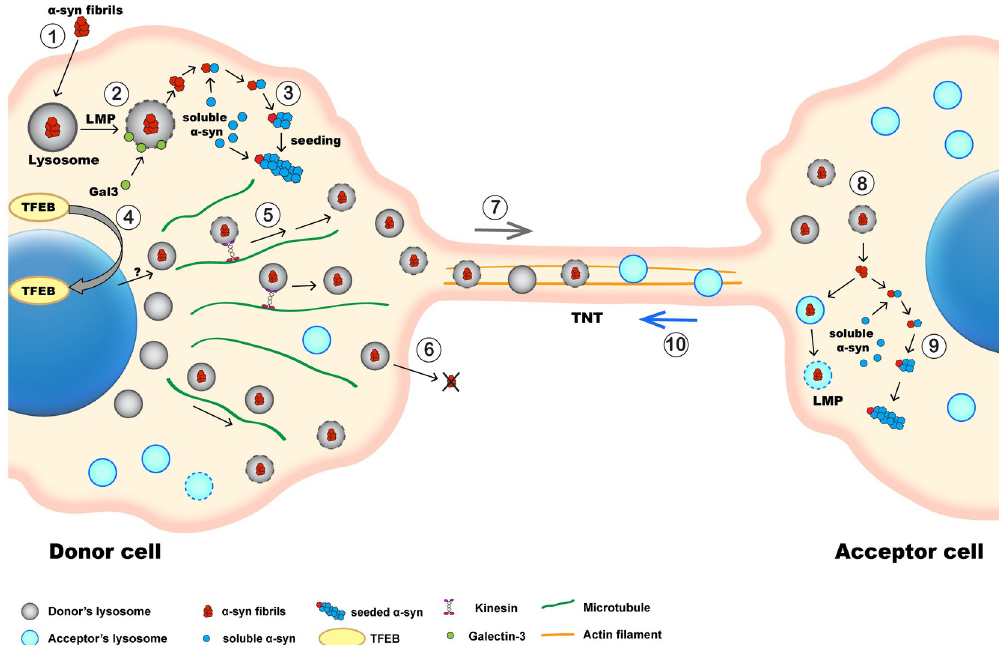
Fig 11. Working model. (1) α -Syn fibrils localize to lysosomes following their uptake. (2) α -Syn fibrils induce LMP (i.e., recruit Gal3 to the ruptured lysosomes) in donor cells following their uptake, allowing their escape from lysosomes. (3) α -Syn fibrils interact with soluble α -syn and induce seeding in donor cells. (4) Following α -syn fibrils internalization, TFEB translocates to the nucleus. (5) Lysosomes (possibly under LMP, as their pH is higher and lysosomal activities is lower) having the α -syn fibrils move toward the cell periphery. (6) Peripheral lysosomes are not preferentially exocytosed. (7) Lysosomes having α -syn (both under LMP or not) are transferred to acceptor cells along with healthy lysosomes. (8) α -Syn fibrils induce LMP following their transfer to acceptor cells. (9) α -Syn fibrils induce further seeding following their transfer to acceptor cells. (10) Acceptor cells transfer healthy lysosomes to donors. α -syn, α -synuclein; Gal3, Galectin-3; LMP, lysosomal membrane permeabilization; TFEB, transcription factor EB; TNT, tunneling